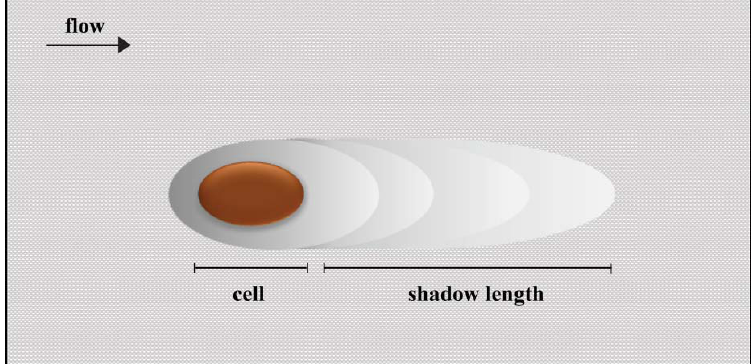
Figure 1. The hydrodynamic blocking effect. The area blocked by an adhered cell where further cell adhesion is prohibited is represented by the shadow.